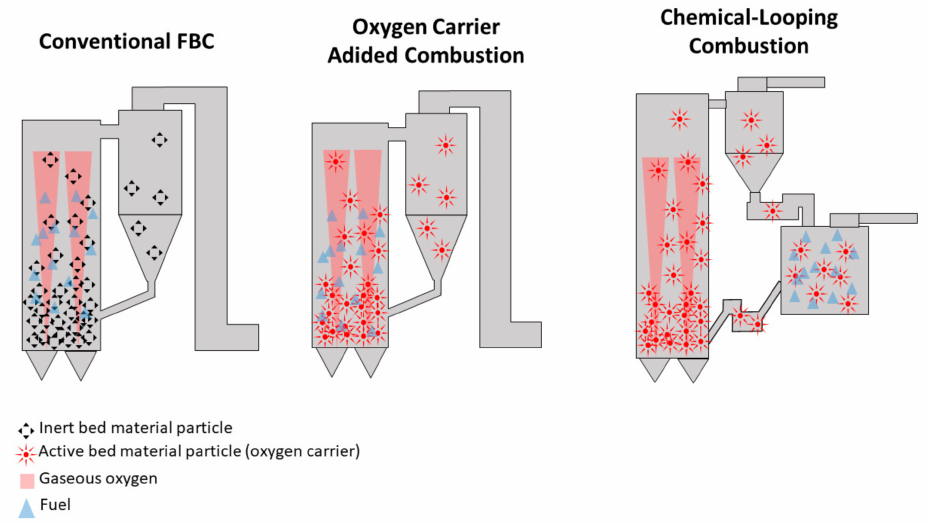
Figure 2. Schematic representation highlighting the main differences between conventional FBC ( left ), OCAC ( middle ) and CLC ( right